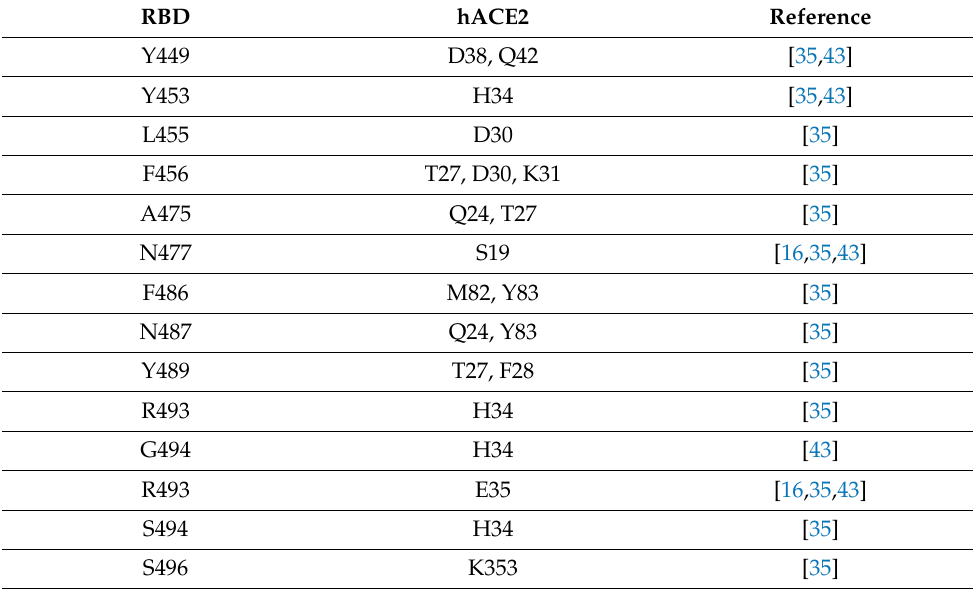
Table 3. Residue–residue interactions between Omicron RBD and